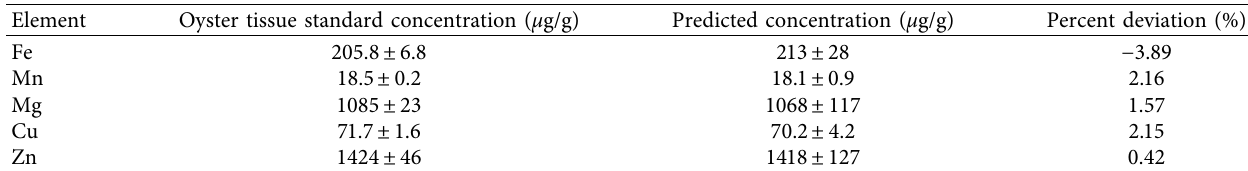
Table 1: Summary of certified versus predicted concentrations of iron, manganese, magnesium, zinc, and copper in oyster tissue (NIST 1566B).